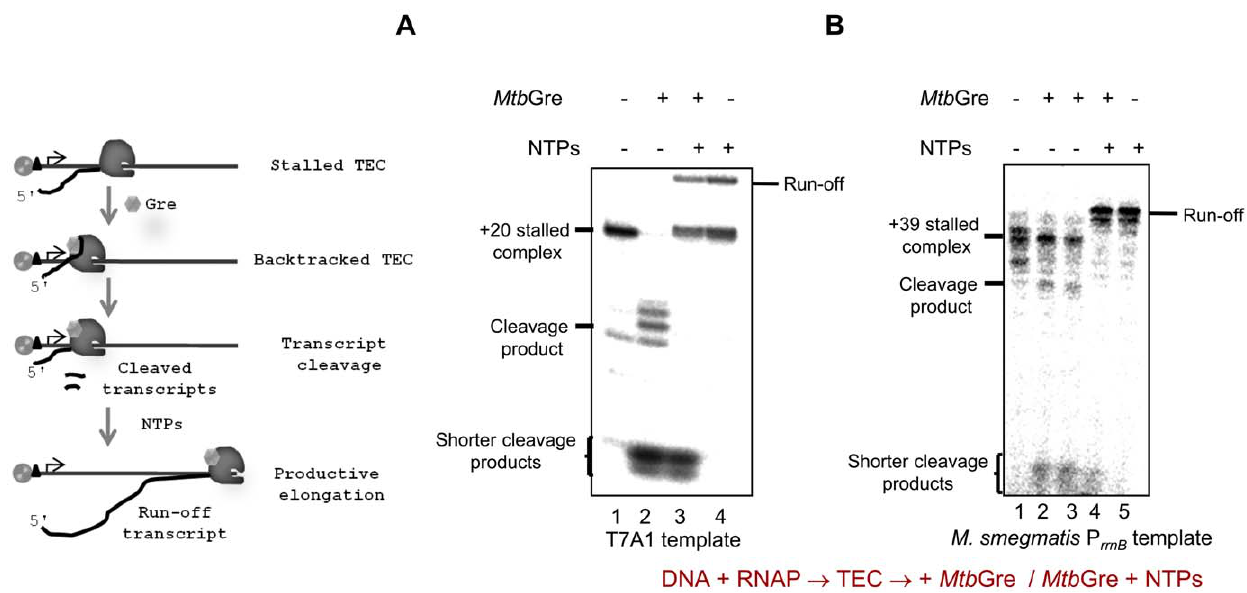
Figure 5. RNAP can restart transcription elongation after transcript cleavage by Mtb Gre. The starting materials in all the experiments were purified stalled complexes with radiolabeled RNA. ( A ) Cleavage-restart assay on T7A1-TEC. The scheme on the left depicts the reaction process. The TEC was incubated without (lane 1) or with Mtb Gre (lane 2 and 3), or NTPs (lane 3 and 4), as indicated. ( B ) Similar assay was carried out on M. smegmatis P rnB promoter template (the RNAP stalls at + 39 position in the absence of UTP in the reaction mix). Transcripts were analyzed by resolving on 20% urea